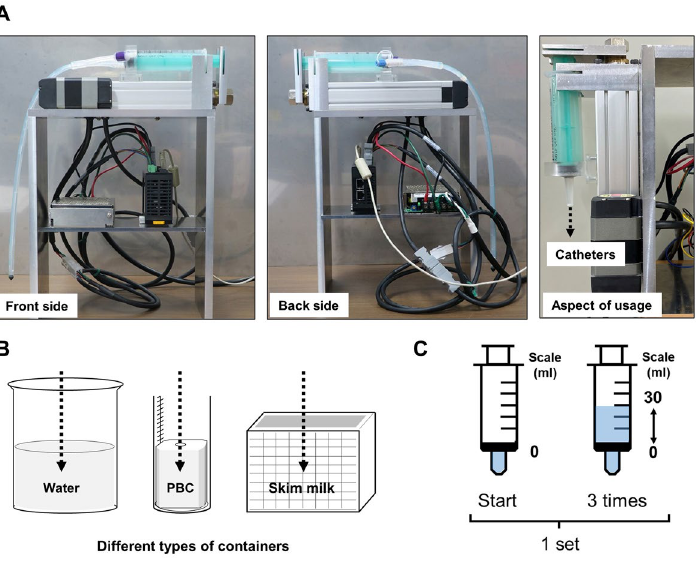
Figure 2. An automatic irrigation device. An automatic irrigation device for a 60 ml catheter tip syringe was used to repeat a predetermined movement at a constant velocity. ( A ) Detailed photographs of the device. ( B ) The tip of each catheter, attached to a syringe, was inserted into different types of containers appropriate for the experiment. ( C ) The syringe was set to start operation from the 0 scale, pulled to 30 scale, and pushed to 0 scale, repeating the operation three times. This series of operations was considered in a single